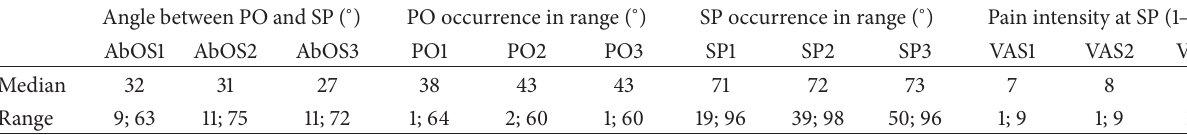
Table 1: Descriptive statistics.